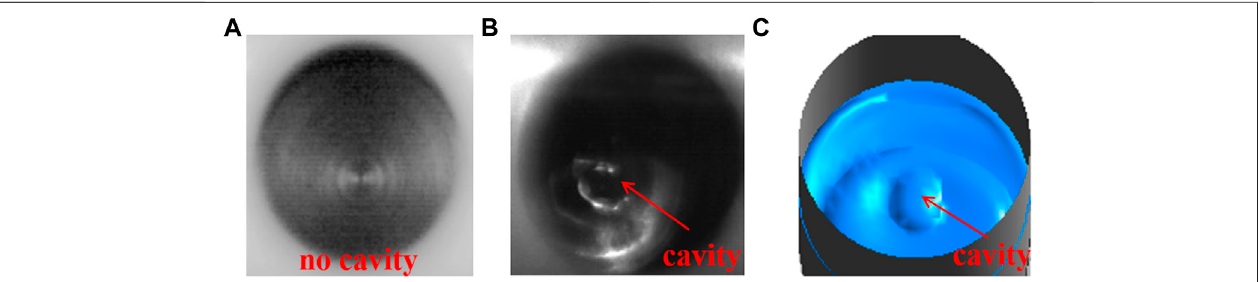
FIGURE6| Comparisonofexperiment andsimulation: (A) nocavityofexperimentdiagram, (B) cavityofexperimentdiagram,and (C) cavityofsimulation diagram.